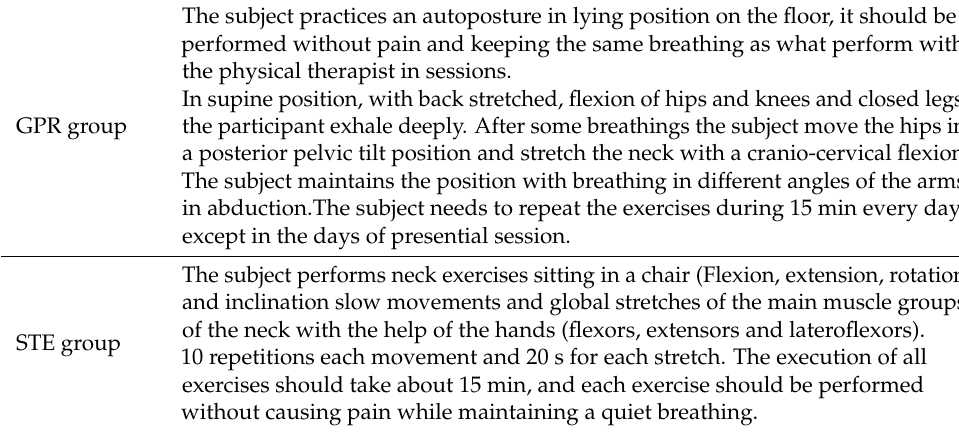
Figure 3. Specific Therapeutic Exercise intervention. Exercises with visual feedback with a laser sensor (Motion Guidance).